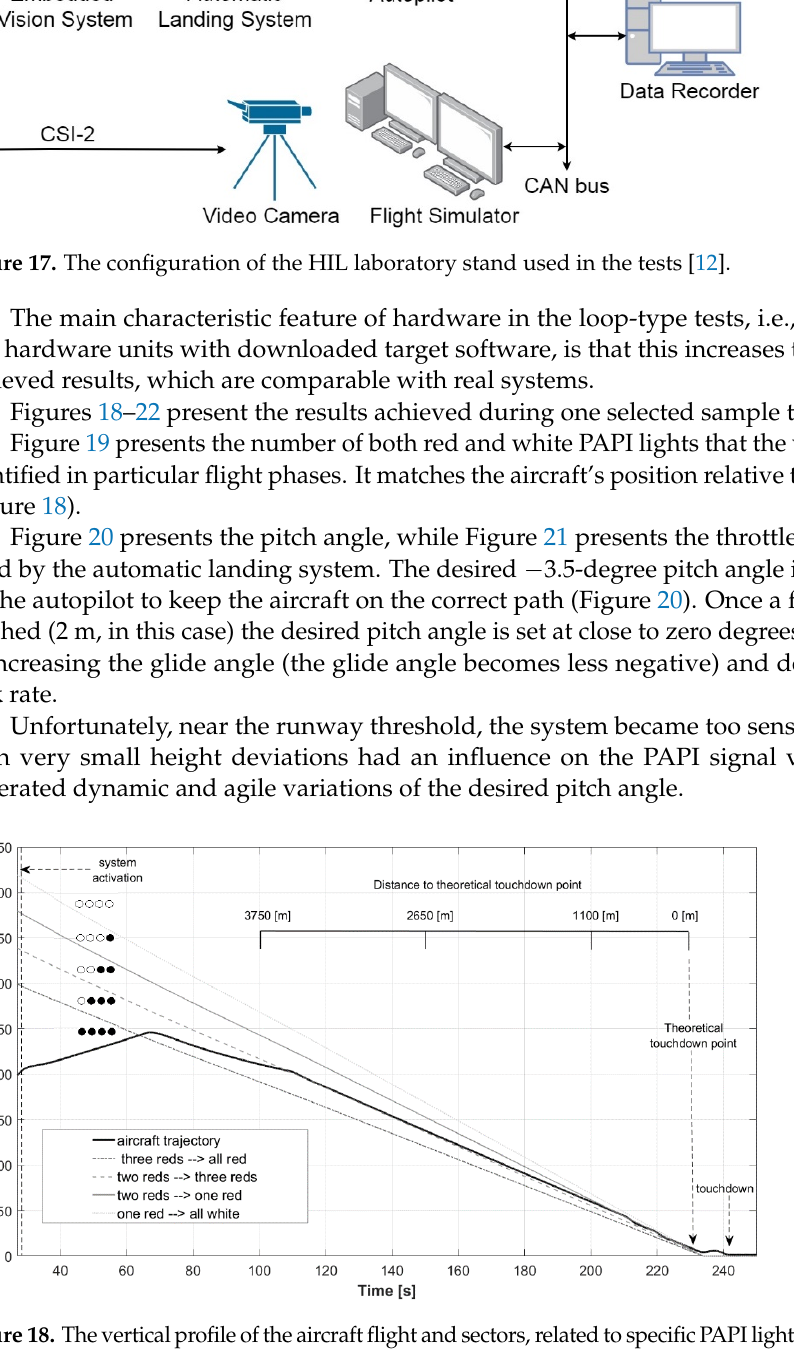
Figure 19. The number of both red and white PAPI lights identified by the vision system. Figure 20. The pitch angle commanded by the automatic landing system, as maintained by the autopilot.